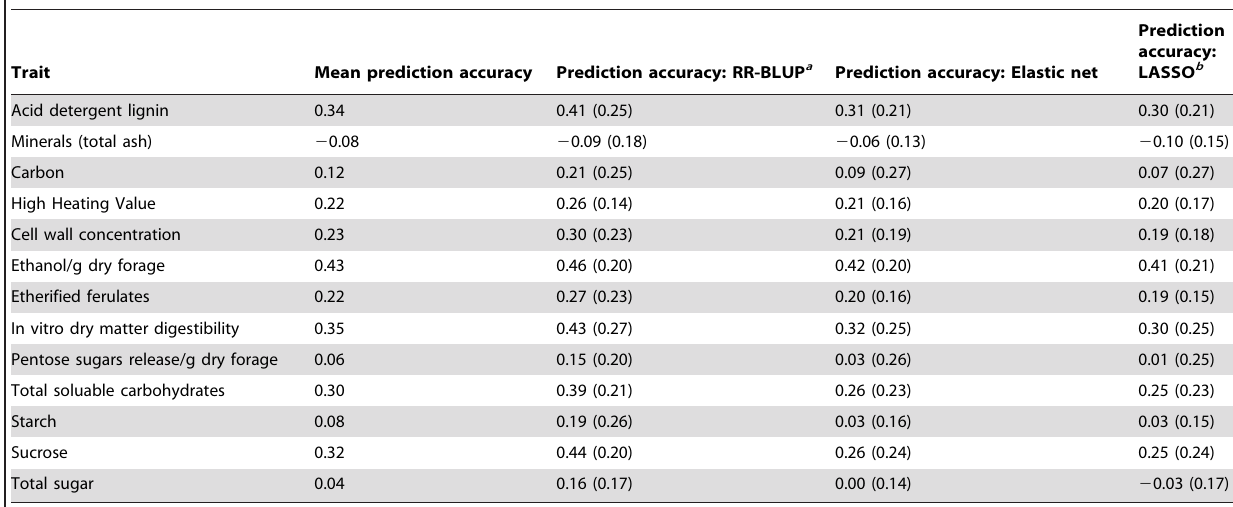
Table 5. Prediction accuracies of 13 quality traits in a switchgrass association panel.